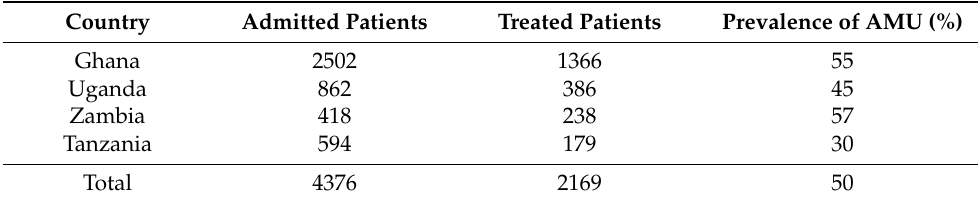
Table 2. Prevalence of antimicrobial use in four countries included in PPS. Country Admitted Patients